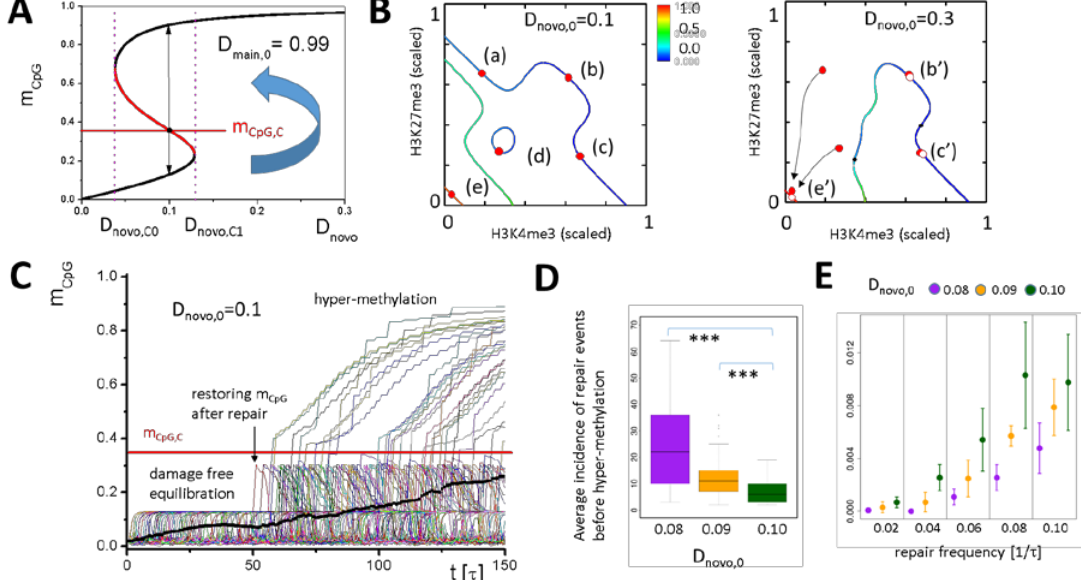
Figure 5. Hyper-methylation induced by increased de novo DNA methylation activity. ( A ) The DNA methylation level, m CpG , depends on the de novo DNA methylation activity. Within the bistable region [D novo,C0 D novo,C1 ], the threshold level m CpG,C defines whether m CpG reaches the high or low methylation state. Increasing the de novo DNMT activity above D novo,C1 renders low DNA methylation states unstable. ( B ) At D novo,0 = 0.3, this applies to the H3K27me3 and the unmodified state with low DNA methylation (stable states at 0.1: solid circles, at 0.3: open circles, color code lines: DNA methylation level). ( C ) Simulation of ongoing DNA repair (onset at t = 50 τ , frequency: 0.04 / τ ). A temporary increase of D novo,0 to 0.3 in individual cells (thin lines) increases m CpG . In most cells, the original methylation level is restored after repair in a few cell cycles. In the case of repeated repair, m CpG can exceed m CpG,C , leading to DNA hyper-methylation. Thick line: average DNA methylation. ( D ) The average incidence of repair events before hyper-methylation is higher at lower initial D novo,0 (*** p -values < 1e-5, Kolmogorov–Smirnov test). ( E ) Accordingly, the hyper-methylation probability is lower at a lower D novo,0 , independent of the repair frequency (errors: SD).